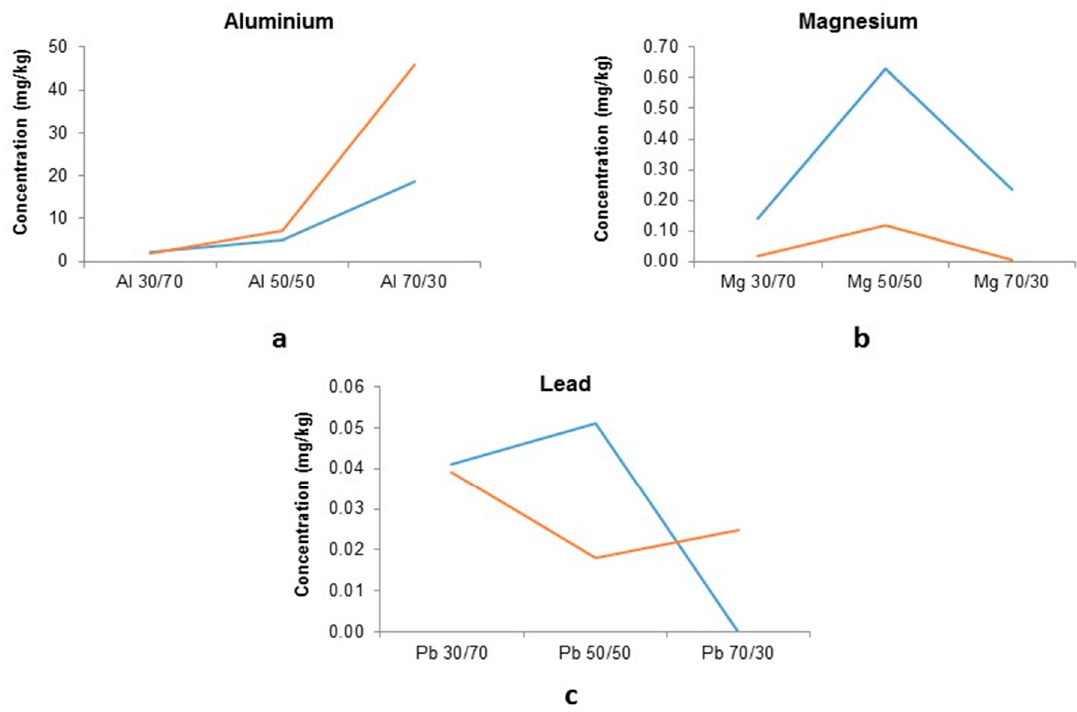
Figure 9. Leached PTEs from stabilised BOF fine sludge: Slag waste: ( a ) Al; ( b ) Mg; and ( c ) Pb different colours represent two different samples from the BOF.